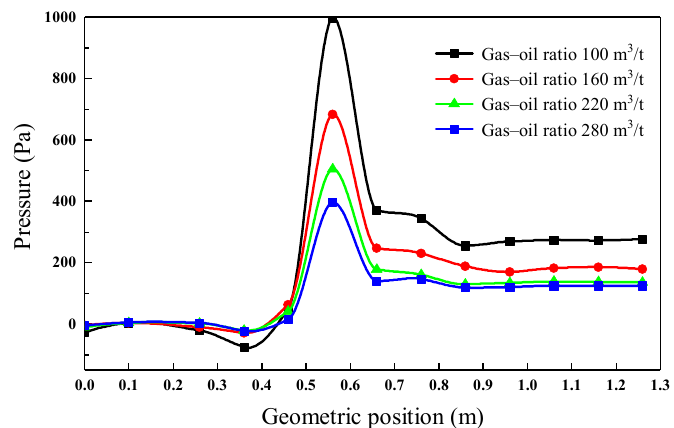
Figure 7. Effect of the gas–oil ratio on the axial pressure distribution of the cylindrical cyclone.